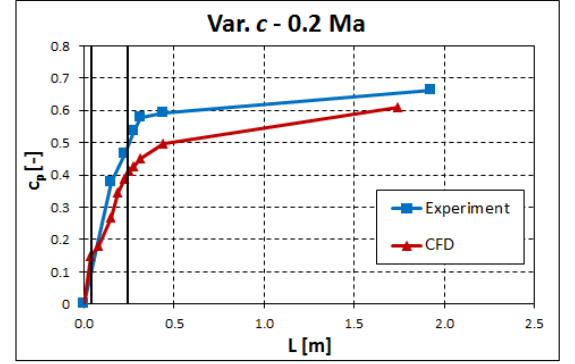
Fig. 21. Result comparison – Variant 𝑐